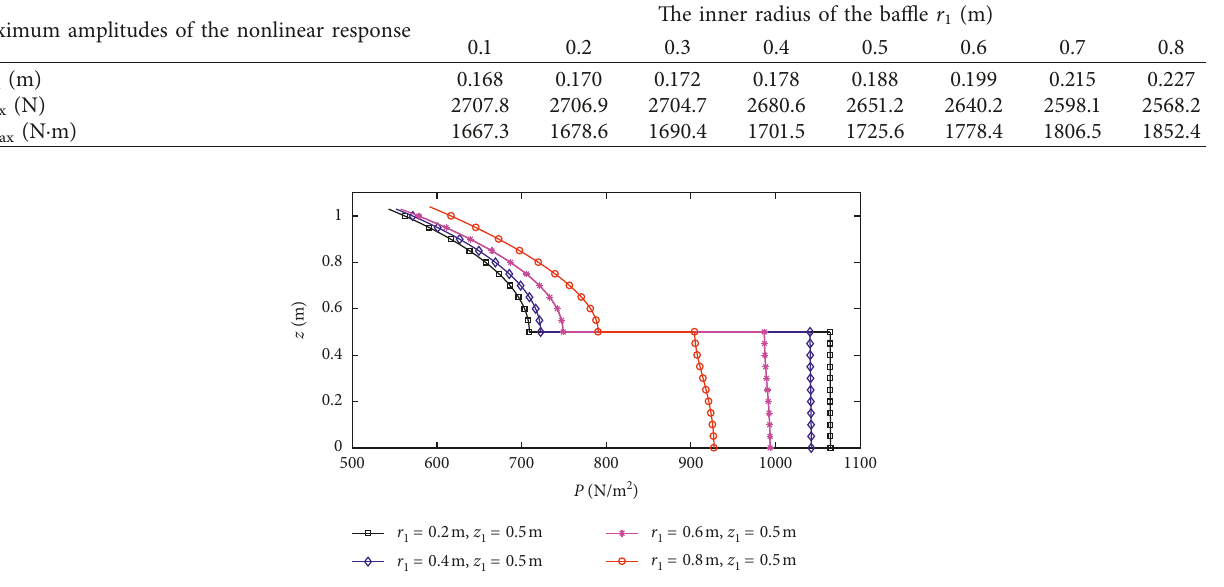
� 0.5 m and r � 0.2m, and M for z max max 1 1